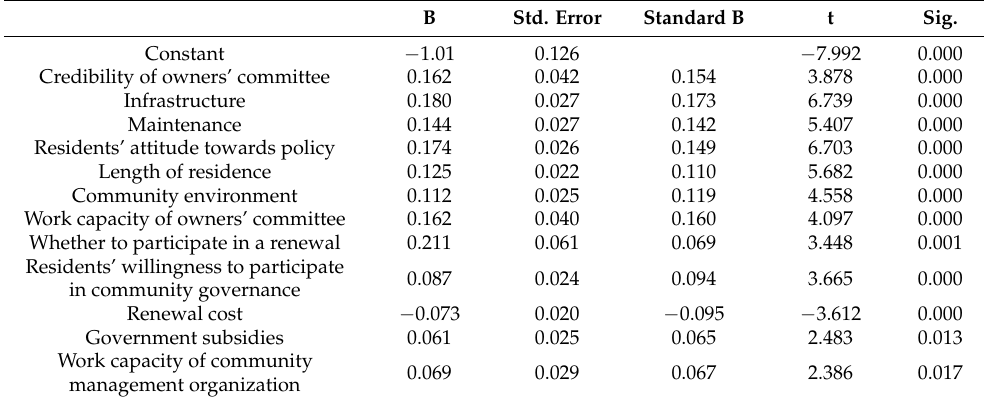
Table 3. Results of stepwise regression.